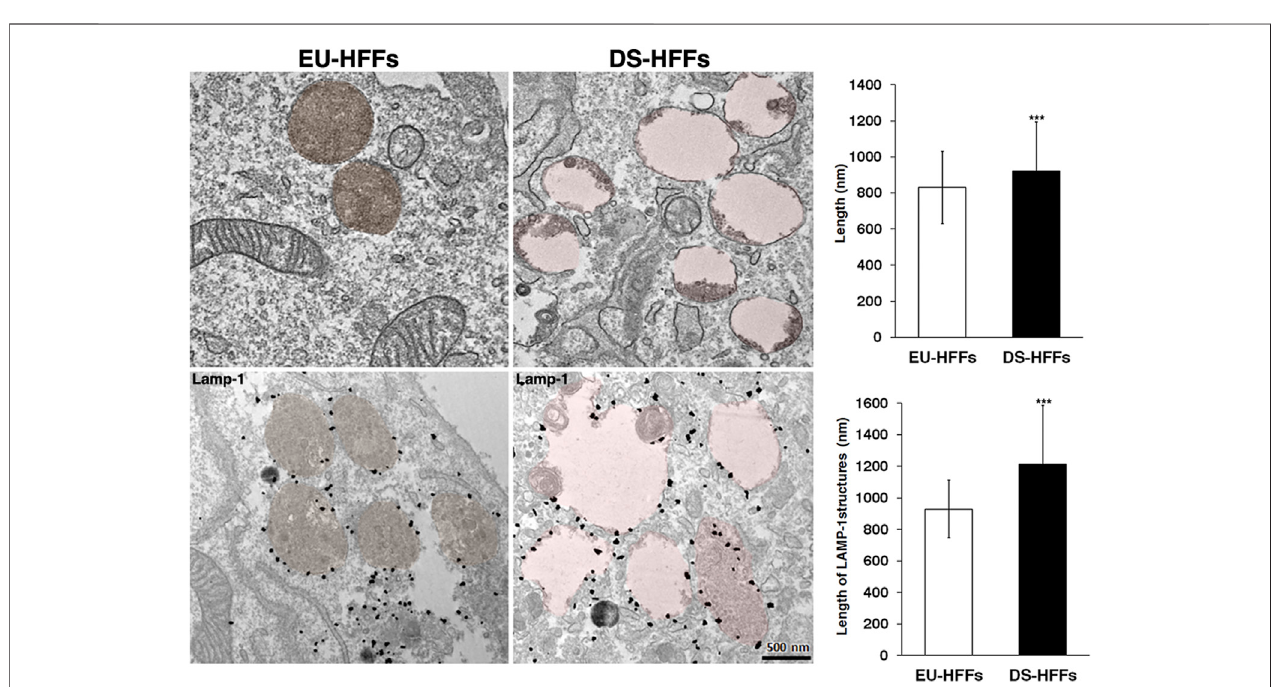
FIGURE9| UltrastructureofendolysosomalcompartmentsisalteredinDSfetal fi broblasts.RepresentativeEMandimmune-EMofEU-HFFsandDS-HFFslabelled withanantibodyagainstLamp-1antibody.Lysosomal-likestructuresaredepictedinbrown(controlcells)andpink(DScells)byfalsecolours.Thelengthoflysosome-like structures in EU-HFFs and DS-HFFs is shown. The bars show the relative mean value ± SD of three (EM) ad two (immuno-EM) independent experiments of two euploid and three trisomic cultures, n ≥ 20 cells. *** p < 0.001, Student ’ s t-test .